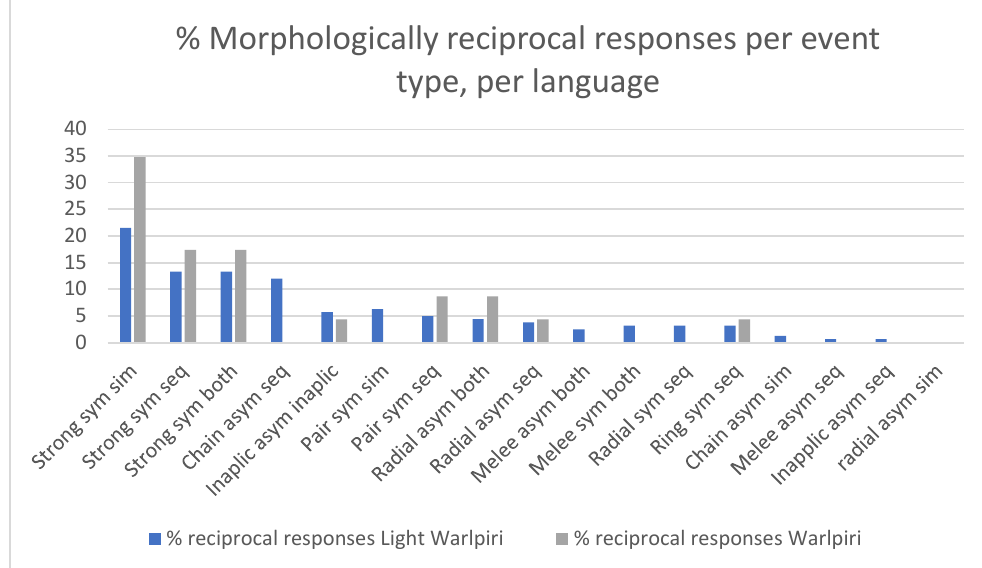
Figure 1. Percent of morphologically reciprocal responses per event type, of all reciprocal responses, per language.